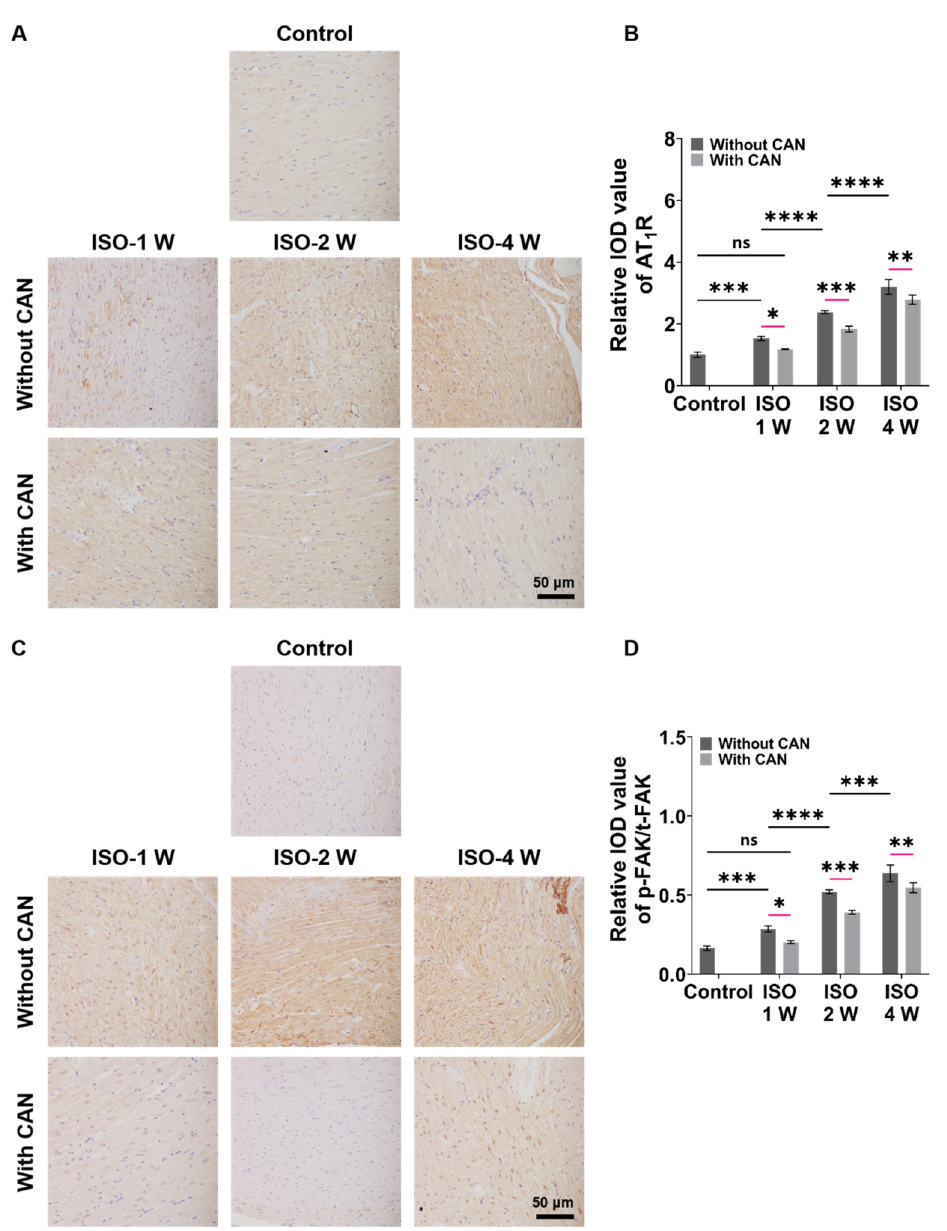
Figure 3. Characterization results of AT 1 R and p-FAK expressions in myocardial fibrosis rats without and with CAN treatment. ( A ) AT 1 R immunohistochemical images of fibrotic myocardium without and with CAN treatment. ( B ) Statistical histograms of relative AT 1 R content of the fibrotic